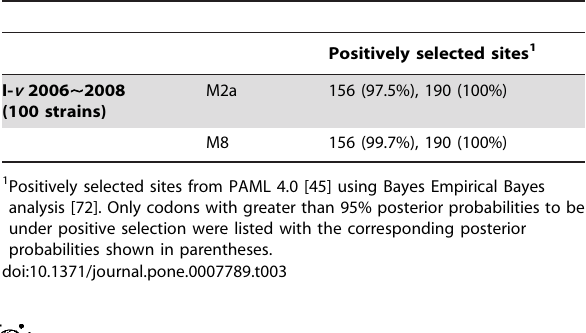
Table 3. Codons under positive selection in HA 1 of human A(H1N1) influenza